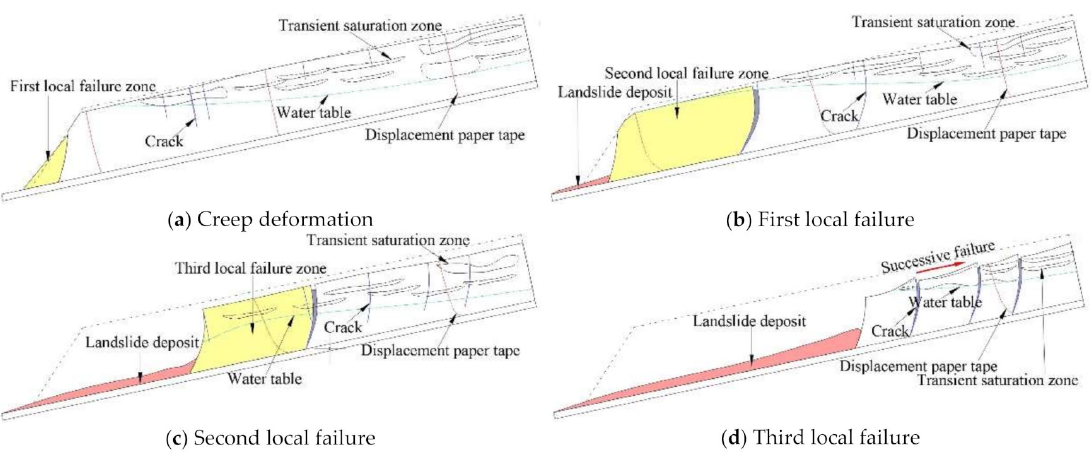
Figure 12. Water table, cracks and failure of the slope at ( a ) 130 min, ( b ) 280 min ( c ) 340 min and ( d ) 600 min.